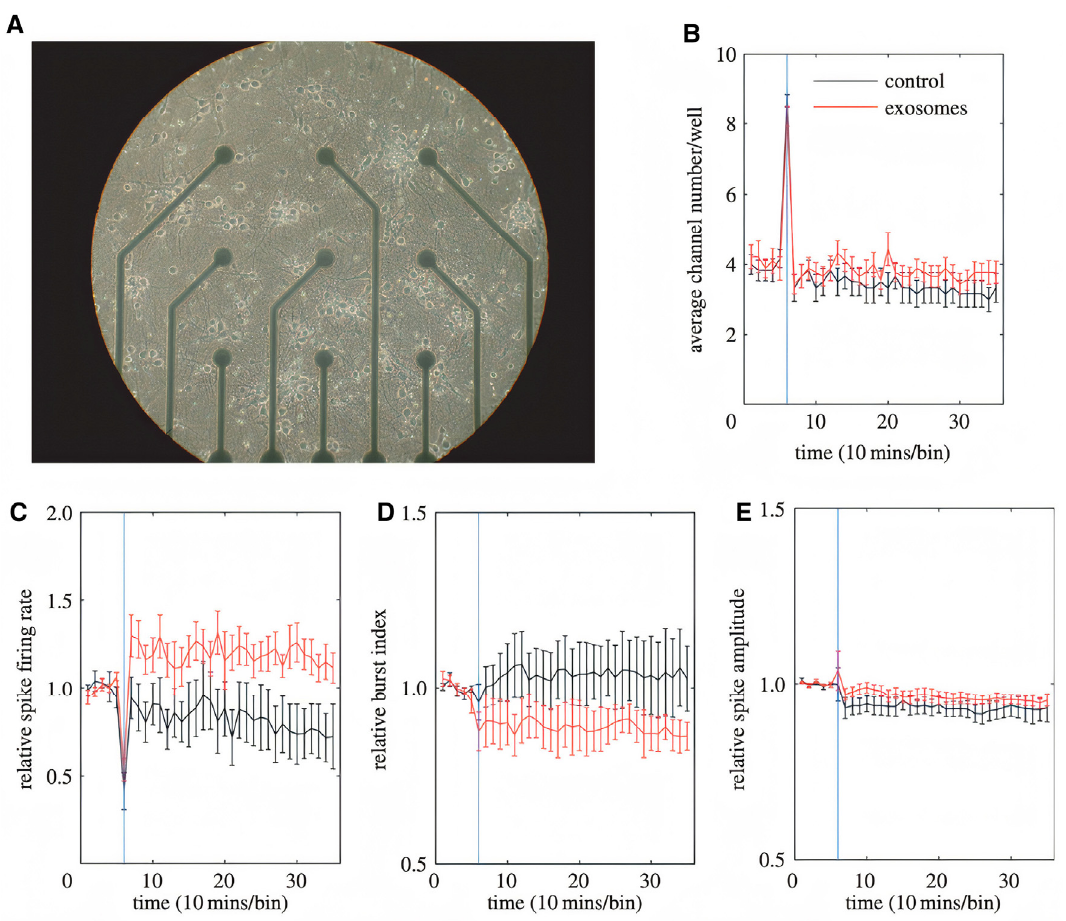
Figure 9. Impact of oligodendroglial exosomes on neuronal electrical activity. ( A ) Image of a 14 DIV pCN culture grown in a 9-channel MEA. Electrode spacing is 200 mm. ( B – E ) Recordings were performed at DIV 14. The blue vertical line indicates the application of pOL exosomes (red graph, n ¼ 9) or sham control (black graph, n ¼ 6) after 1 h of recording. Average channel number/well ( B ), relative spike firing rate ( C ), relative burst index ( D ), and relative spike amplitude ( E ) are depicted over 6 h of recording. Error bars+s.d. (* p , 0.05; Student’s t-test) [78]. Figure and caption reproduced with permission from Royal Society.